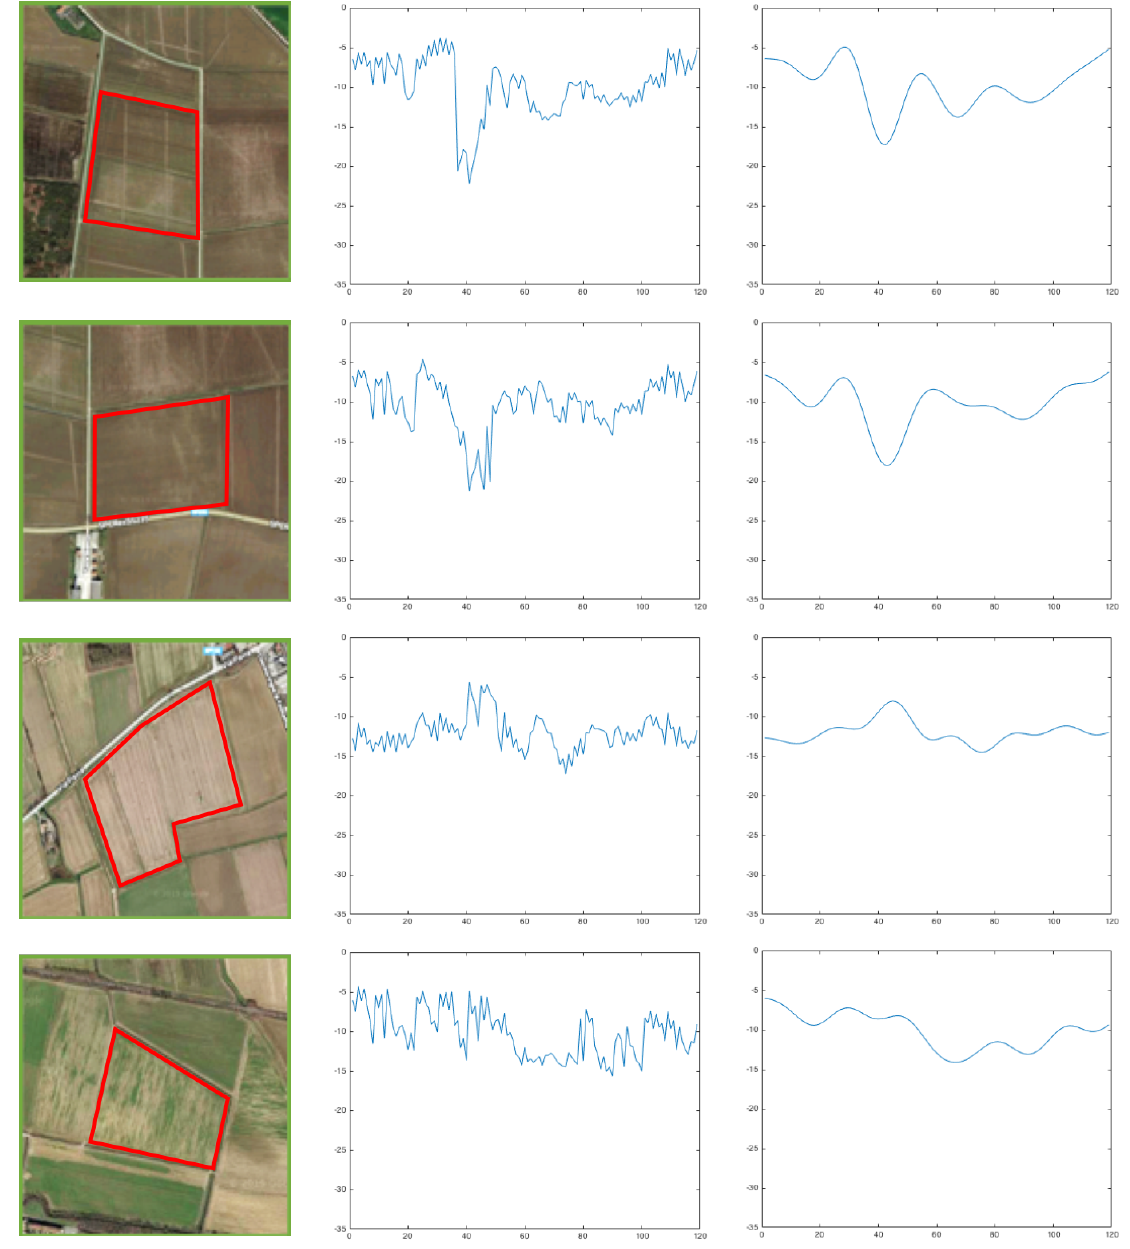
Figure 9. Some examples of field samples and corresponding original and low-pass filtered SAR time-series. The two upper examples refer to rice paddy fields, whereas the two lower ones refer to other types of